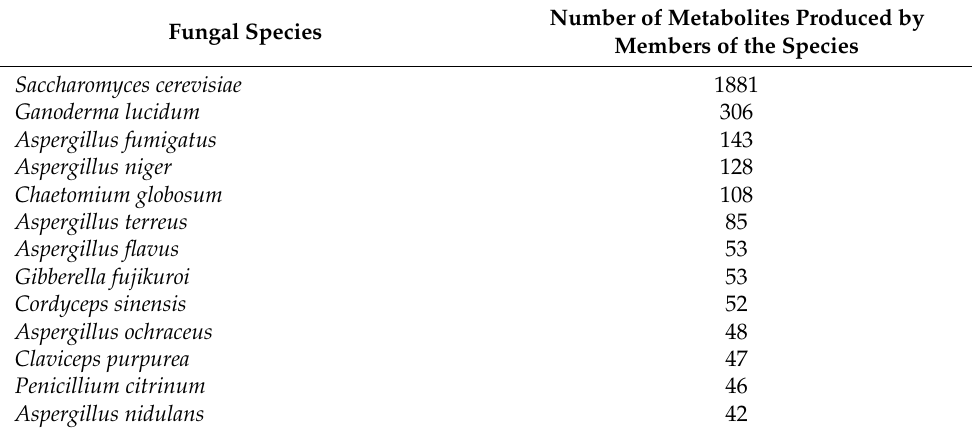
Table 6. Species of fungi with high production of metabolites (on 26 April 2022). Fungal Species